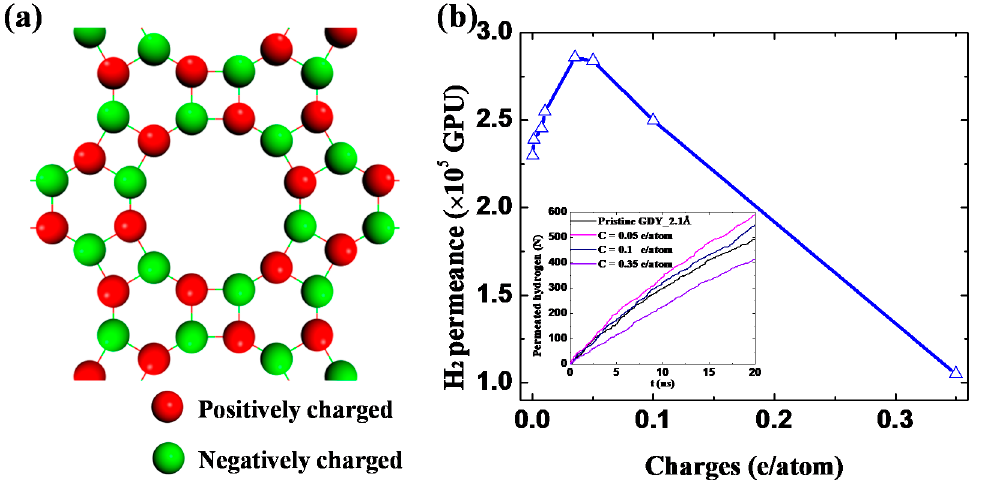
Figure 8. The effect of the surface charges on gas permeation. ( a ) The distribution of charges on the network of GDY_2.1Å; ( b ) H 2 permeance of the binary mixture of H 2 /CO 2 as a function of surface charges. (Inset) The time evolution of permeated H 2 molecules through the charged GDYs.